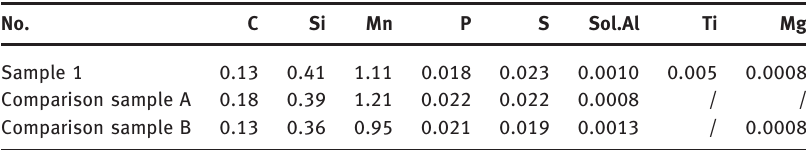
Table 1: Composition of samples (mass fraction/%).